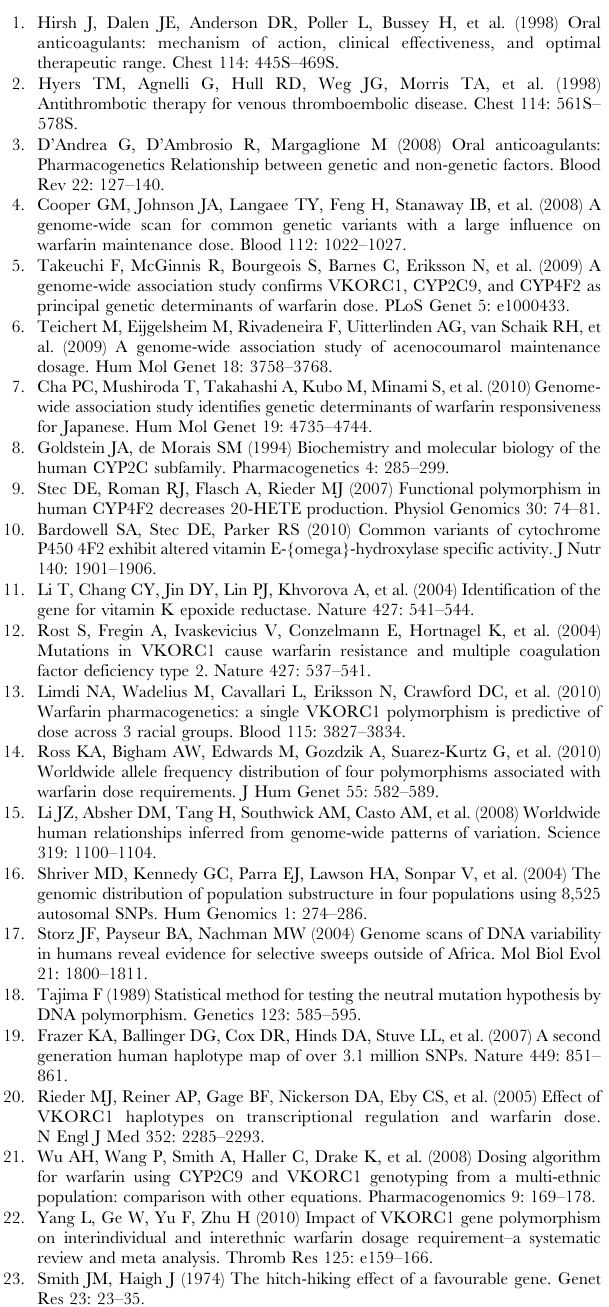
Table S4 Results of the XP-CLR test in the , 500 kb genomic region of the LD block encompassing VKORC1 in East Asia. Table S5 Results of the XP-EHH, iHS tests, inter-regional F ST and global F ST for all SNPs located in the linkage disequilibrium block encompassing VKORC1 in East Asia. Table S6 Description of the 52 HGDP-CEPH samples grouped into seven main geographic